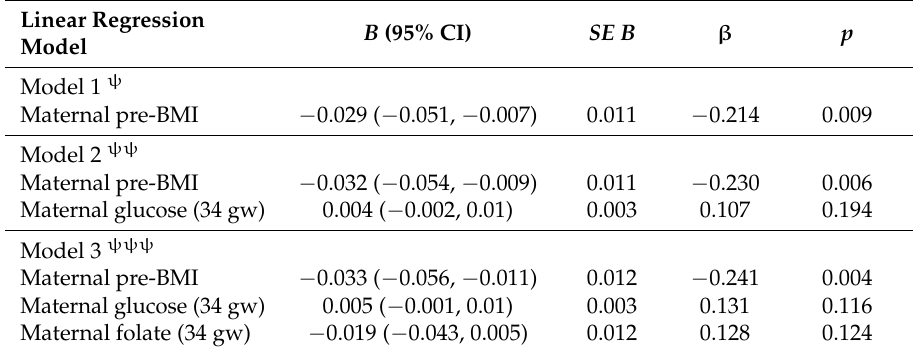
Table 5. Association between placental gene expression of folate receptor alpha ( FOLR1 ) and different predictors in control, overweight and obese pregnant women with or without gestational diabetes ( n =